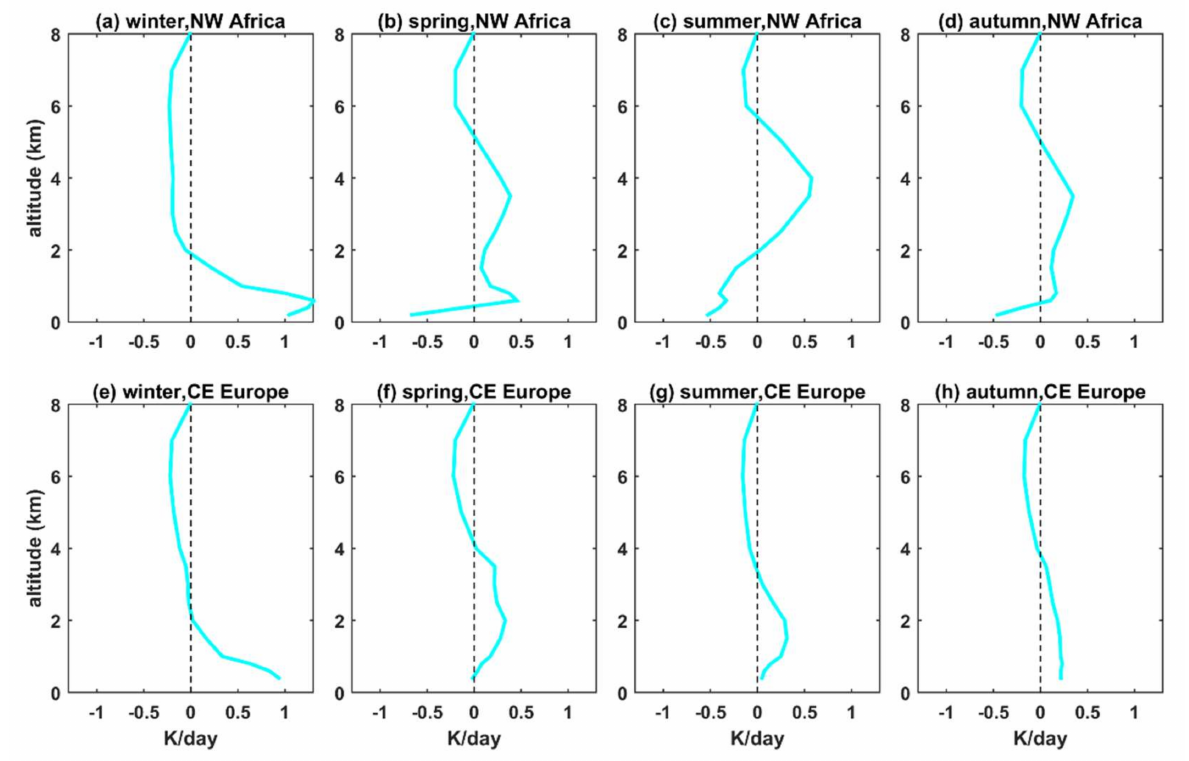
Figure A14. Same as Figure 10, but for SZA = 30 ◦ instead of SZA = 60 ◦ .